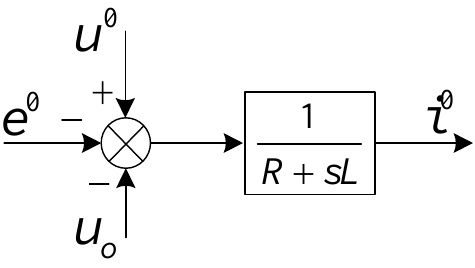
Figure 3. Zero-sequence model of